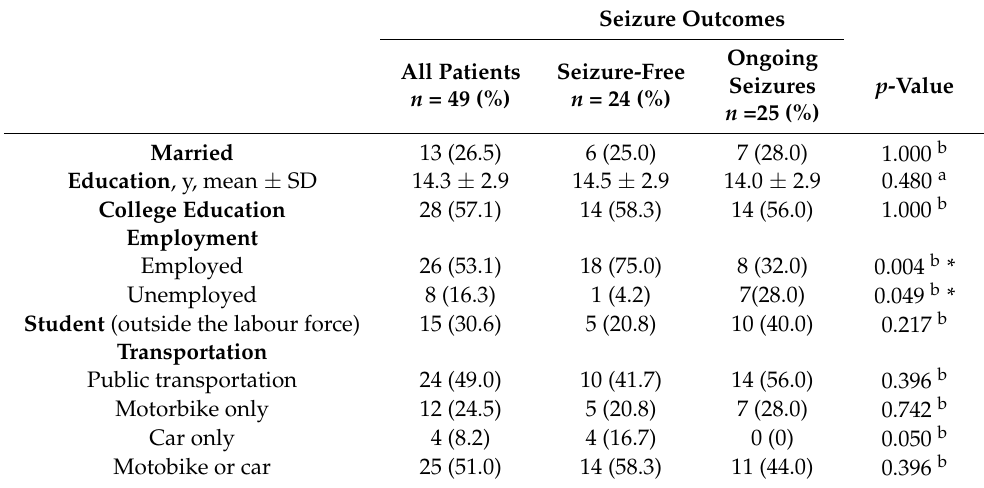
Table 4. Social outcomes’ association with seizure control in the patients with JME.